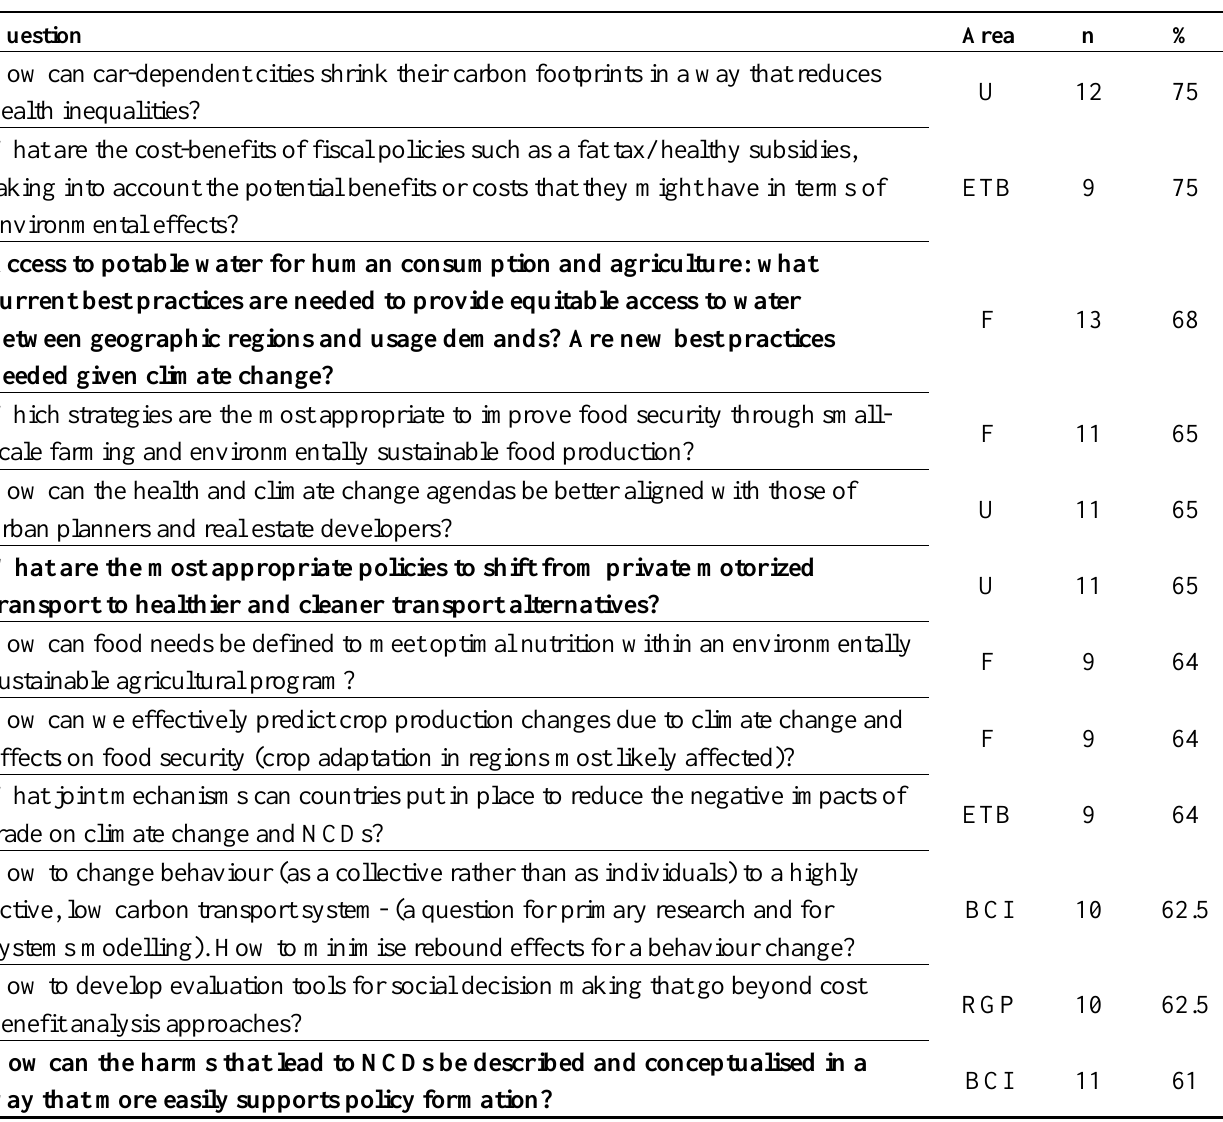
Table 3. Agreement (>60%) to rank question as high priority. NB: Questions also presented in Table 2 are in